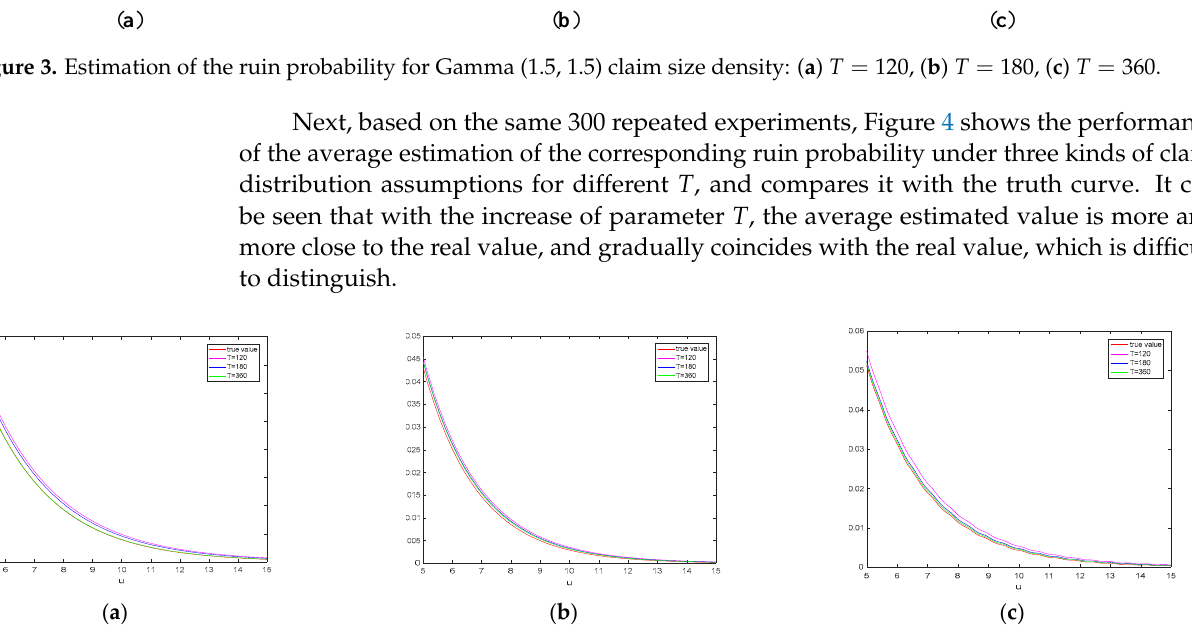
Figure 4. Estimation of the ruin probability: mean curves. ( a ) Exponential claim size density; ( b ) Erlang (2) claim size density; ( c ) Gamma (1.5, 1.5) claim size density.